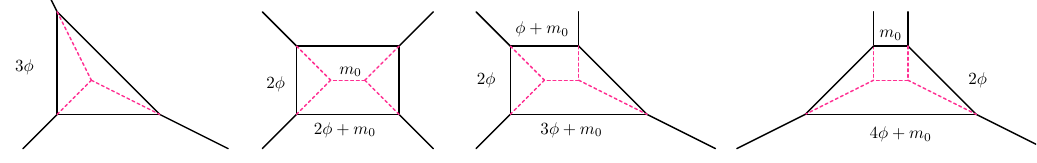
Figure 1 . 5-brane webs for E 0 -theory, SU(2) 0 , SU(2) π , and SU(2) 2 π theories. In geometry, they correspond to local P 2 , F